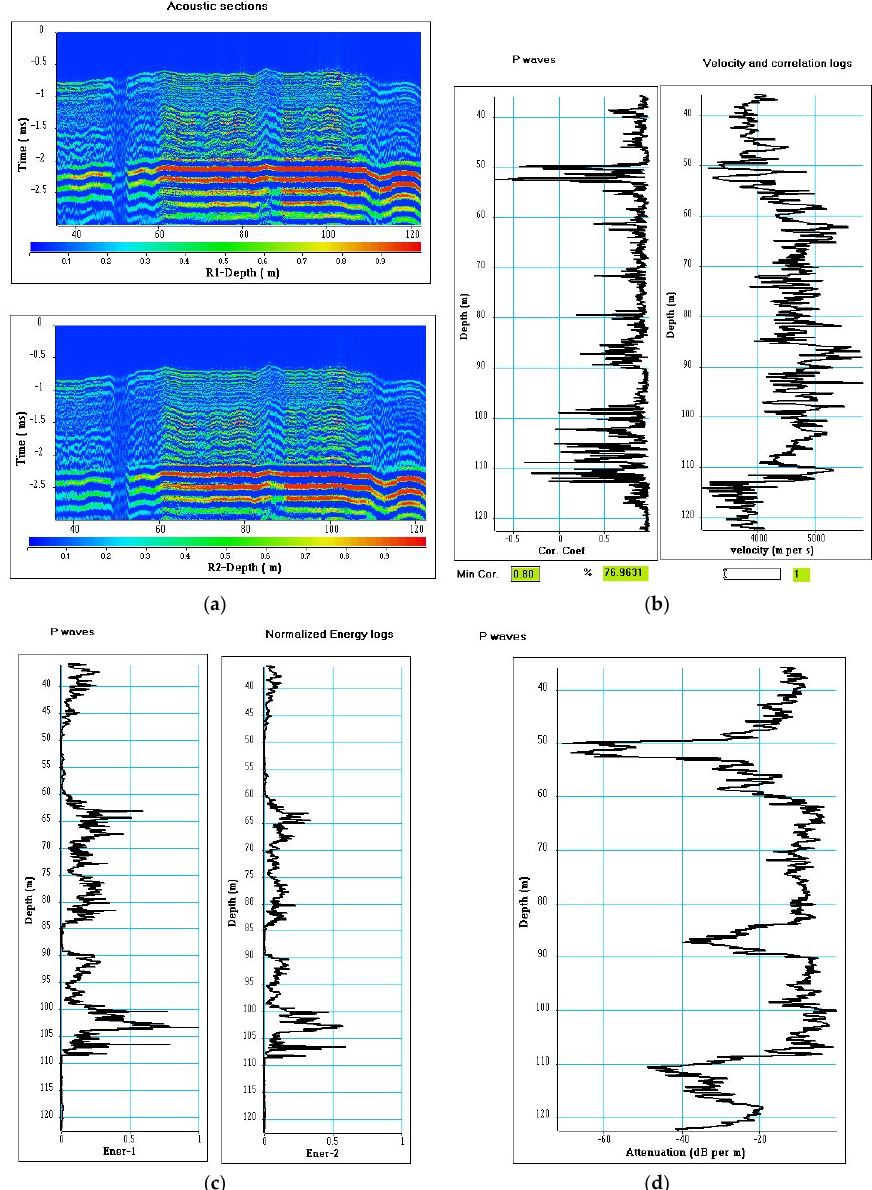
Figure 9. Refracted P ‐ waves. ( a ) Acoustic sections after mute. Vertical axis: recording time in ms, horizontal axis: depth of receiver R1 or R2, color scale: normalized amplitude, ( b ) velocity log and its associated correlation coefficient log, ( c ) normalized energy logs, ( d ) attenuation log.